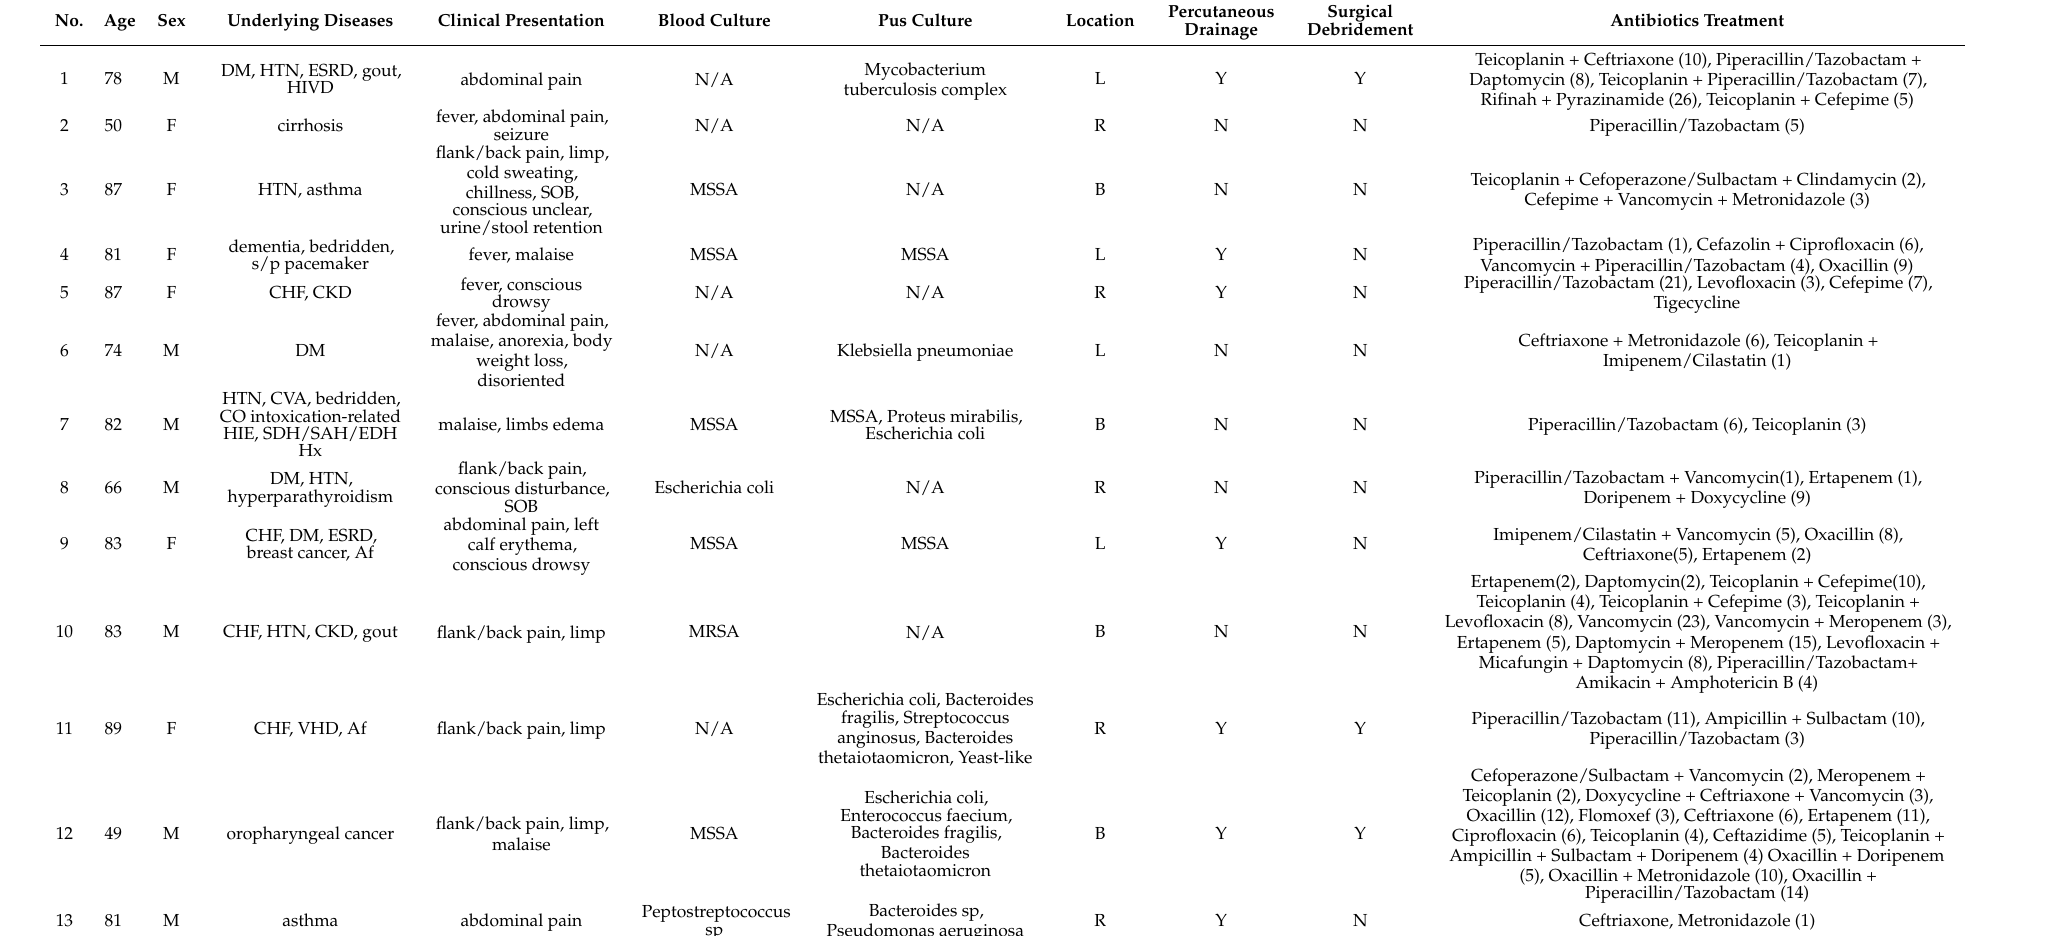
Table 4. Description of patients with iliopsoas abscess who passed away during